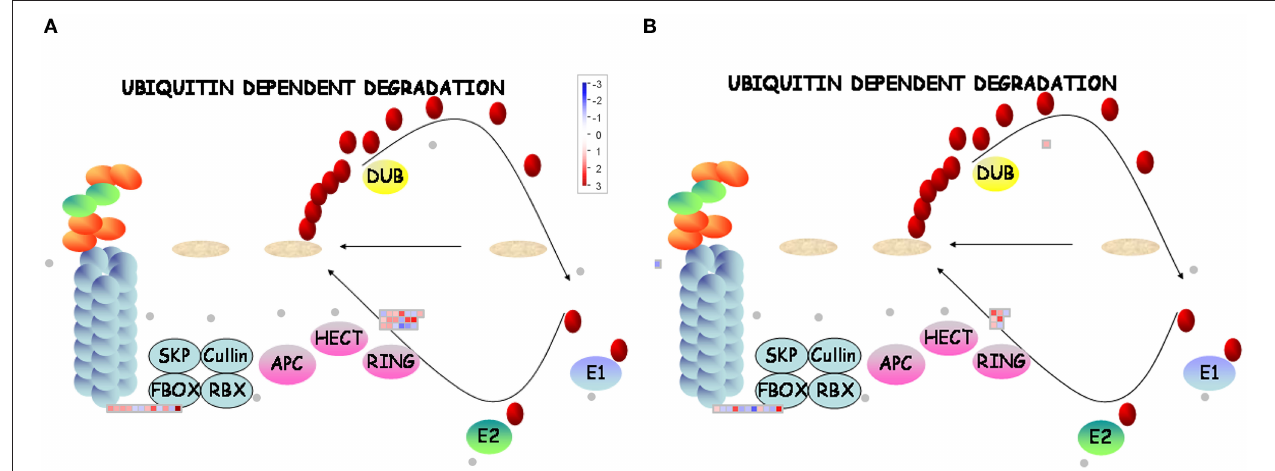
FIGURE 6 | MapMan display of the coordinated changes in the expression levels of genes involved in the ubiquitin-dependent degradation pathway in different dormancy varieties of alfalfa under LT. Shown are DEGs in (D + LT)/D (A) and (ND + LT)/ND (B) under LT condition. Squares represent DEGs, red and blue indicate up- and downregulated genes, respectively. dormancy (D), non-dormancy (ND).